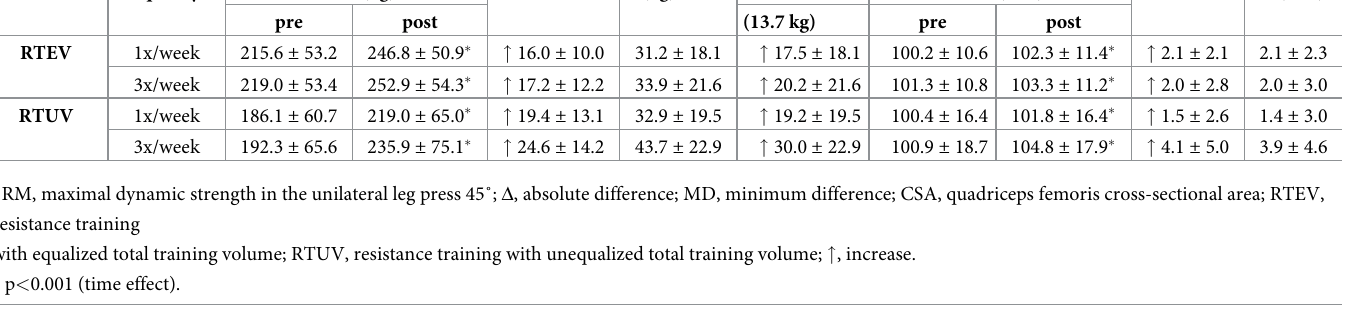
Table 2. Unilateral leg press 45˚ 1RM and quadriceps femoris CSA values for RTEV and RTUV conditions. Conditions